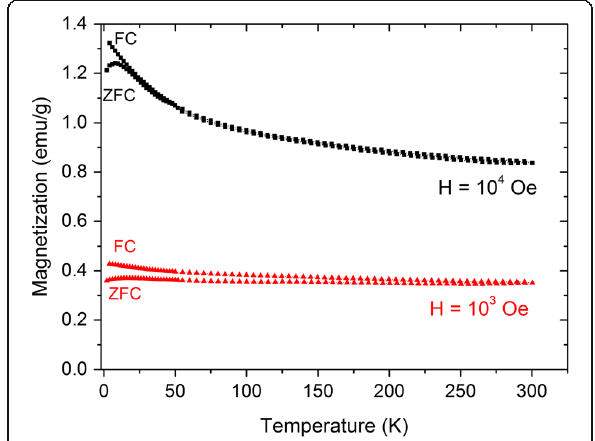
Fig. 11 Temperature dependencies of magnetization measured under ZFC and FC conditions at different magnetic field for the CFTS